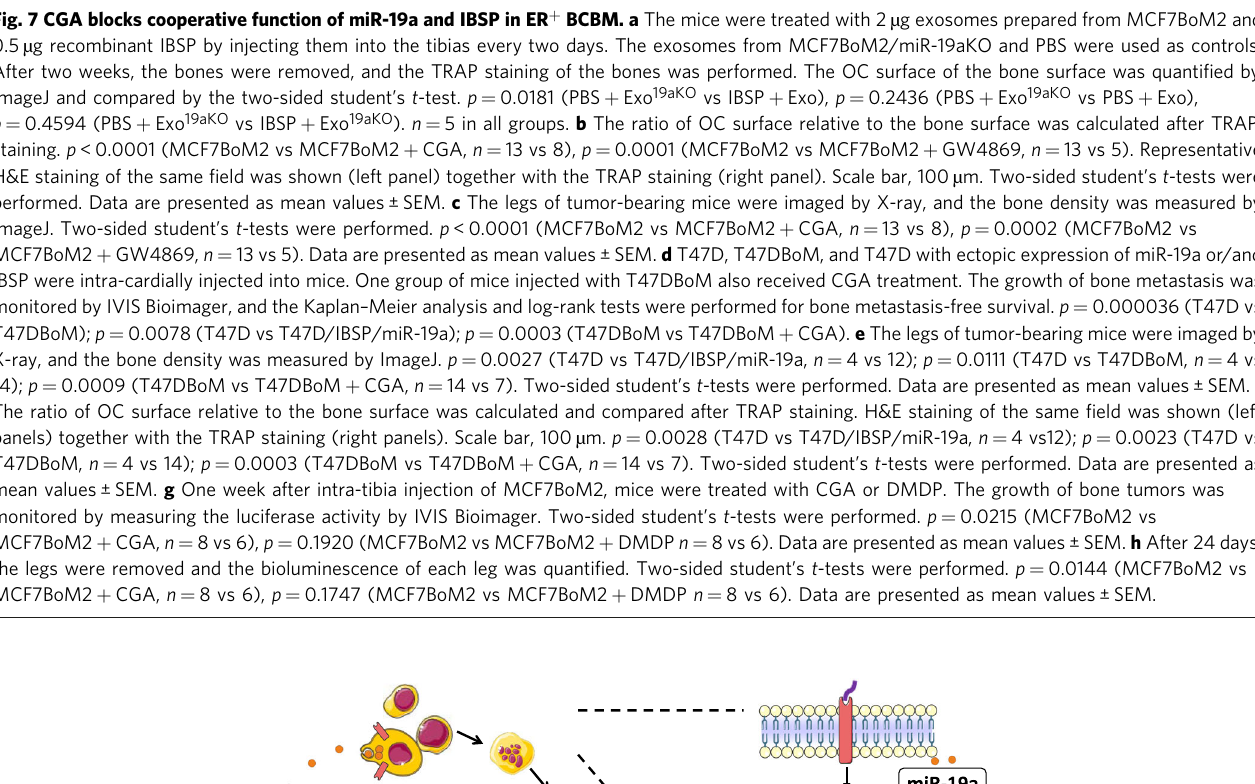
Fig. 8 Proposed mechanism of exosomal miR-19a and IBSP mediated bone metastasis in ER + breast cancer. In the early metastatic niche, ER + breast cancer cells secrete IBSP as a chemoattractant to recruit precursors of OC cells, creating an OC precursor-enriched microenvironment. OC precursors incorporate exosomes from breast cancer cells, and miR-19a is transported into OC precursors. Inside the OC precursors, miR-19a suppresses PTEN expression, activates NF- κ B and AKT pathways, and promotes osteoclastogenesis. Mature OC cells induce bone resorption, liberating growth factors from the bone matrix, which further promote the growth of cancer